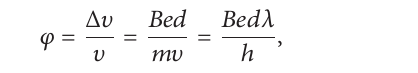
along ⟨100⟩ directions. We measured the distances between satellite spots and the fundamental Bragg reflections